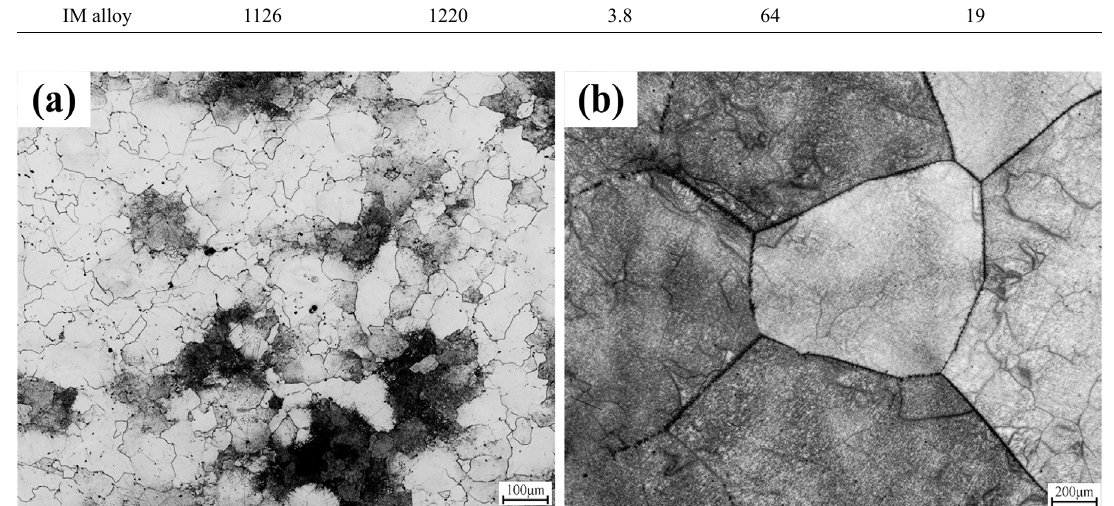
Figure 1. Initial microstructures of Ti-5553 alloys: (a) as-consolidated PM alloy; (b) as-cast IM alloy.